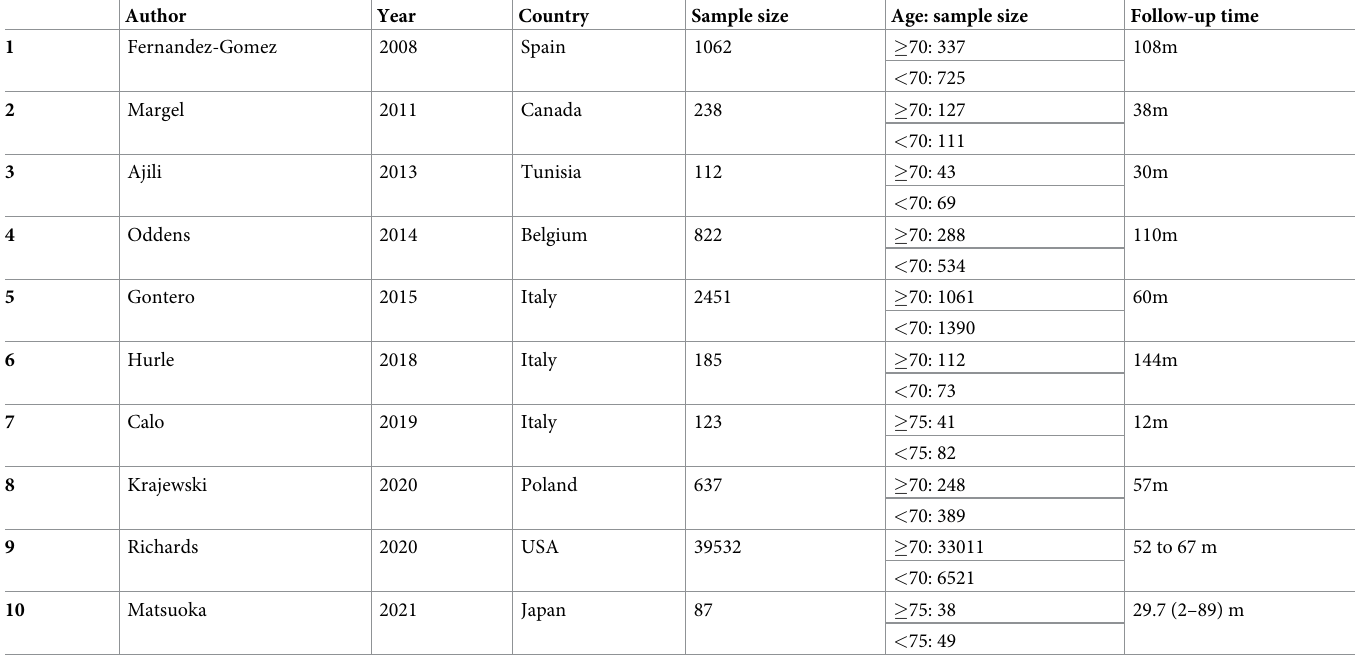
Table 2. Characteristics of the studies included in the meta-analysis.